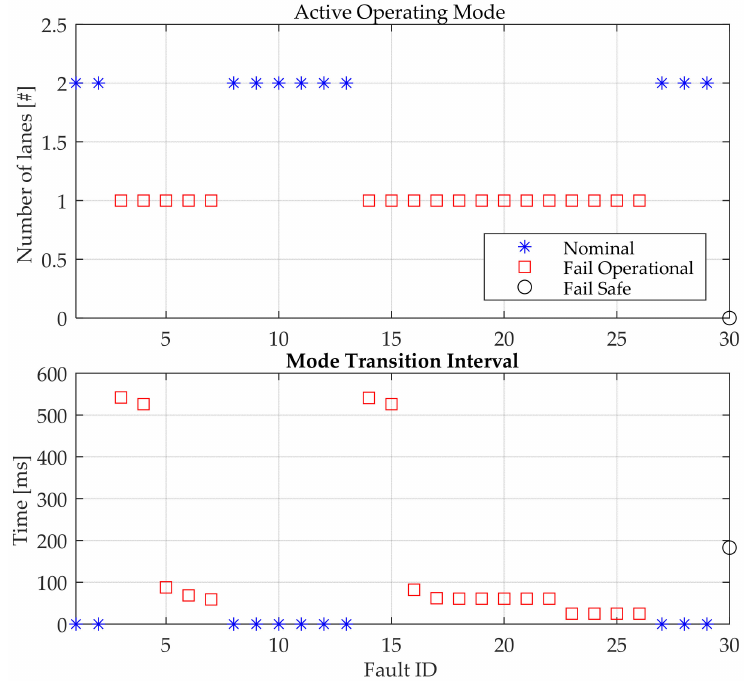
Figure 24. Fault detection and reconfiguration for 30 health conditions in Table